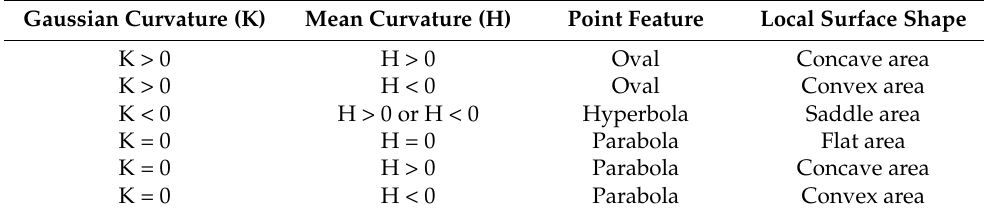
Table 1. Relationship between surface shape and geometric